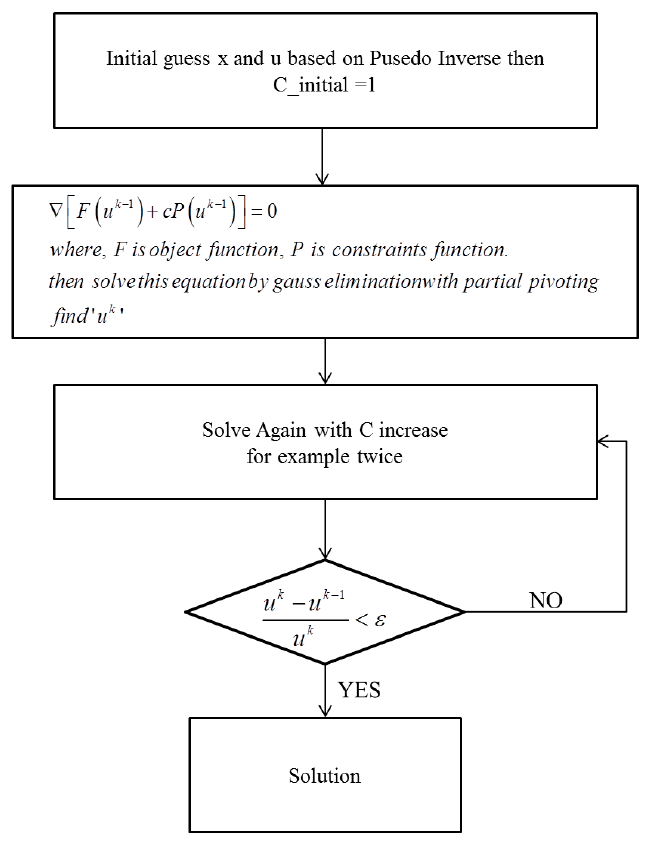
Figure 2. Flow Chart of Penalty Program.